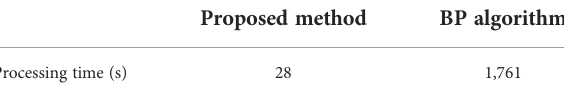
TABLE 3 Processing times of the imaging